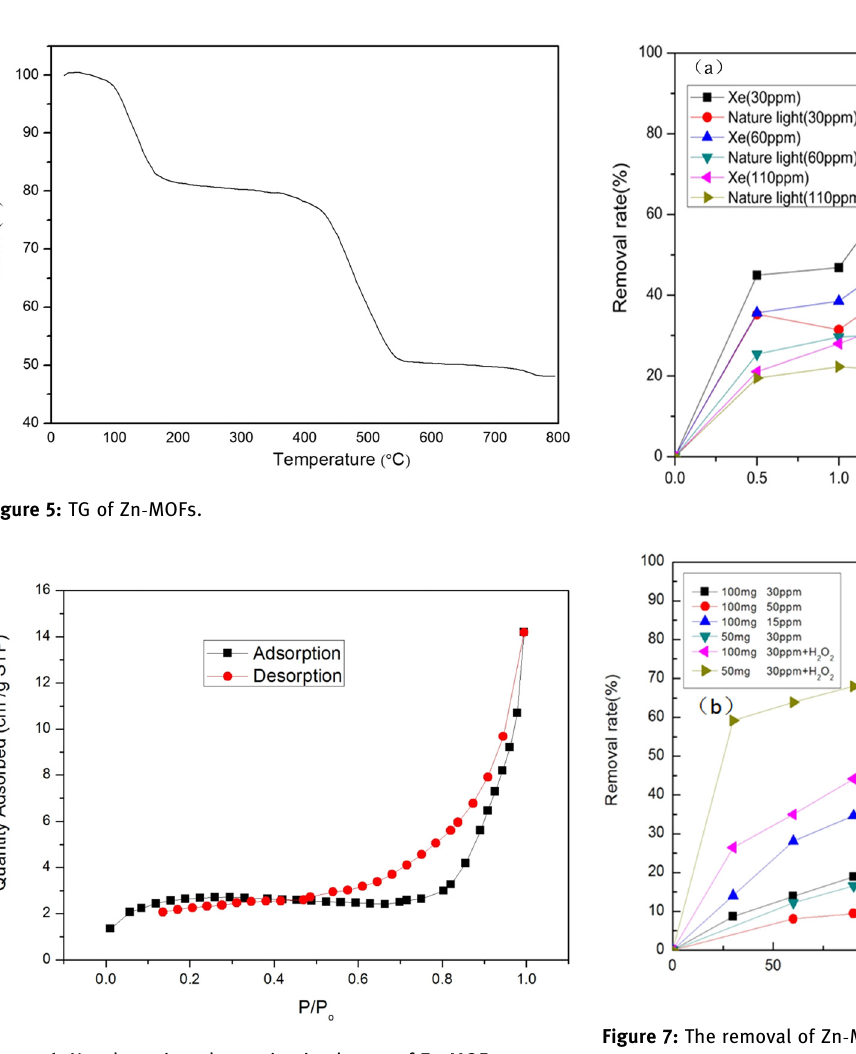
Figure 6: N 2 adsorption – desorption isotherms of Zn - MOFs.